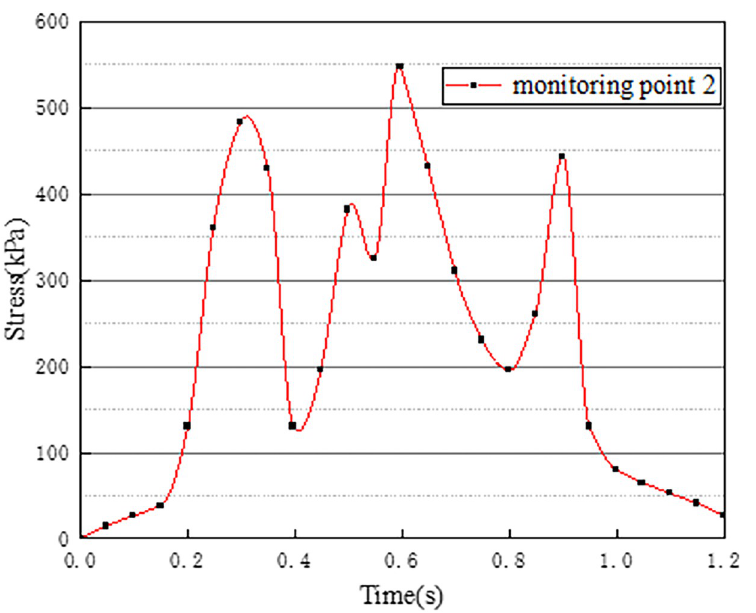
Fig 8. Stress time history curve of monitoring point 2.